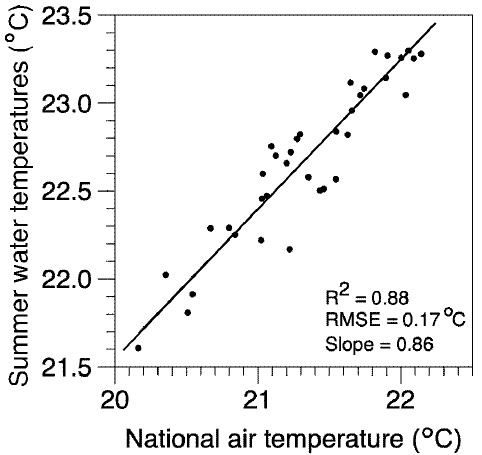
Figure 6. The calculated average annual summer water temperatures for the lakes of the conterminous United States for the years 1981–2018 plotted against the average of the national summer air temperatures during the same years.